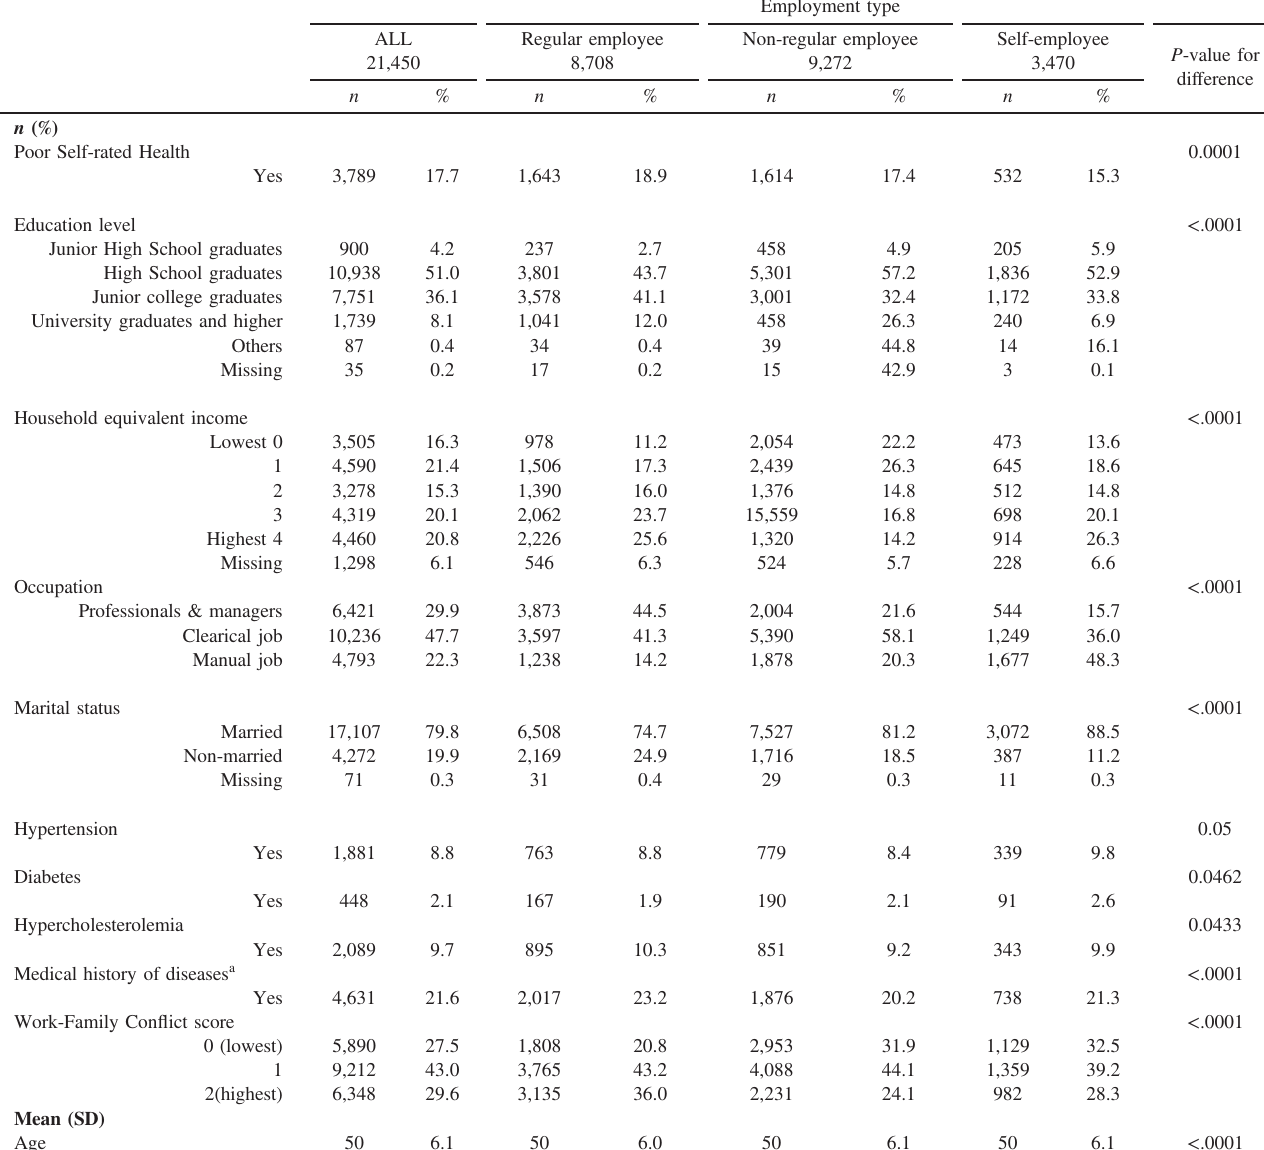
Table 1. Characteristics of study population according to employment status